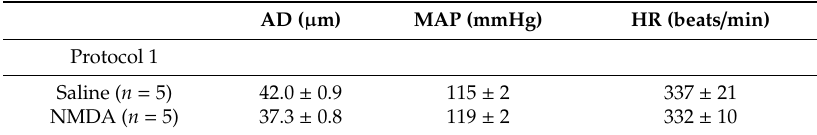
Table 1. Baseline values of retinal arteriolar diameter (AD), mean arterial pressure (MAP), and heart rate (HR) before intravitreal injection of saline or N -methyl- d -aspartic acid (NMDA).